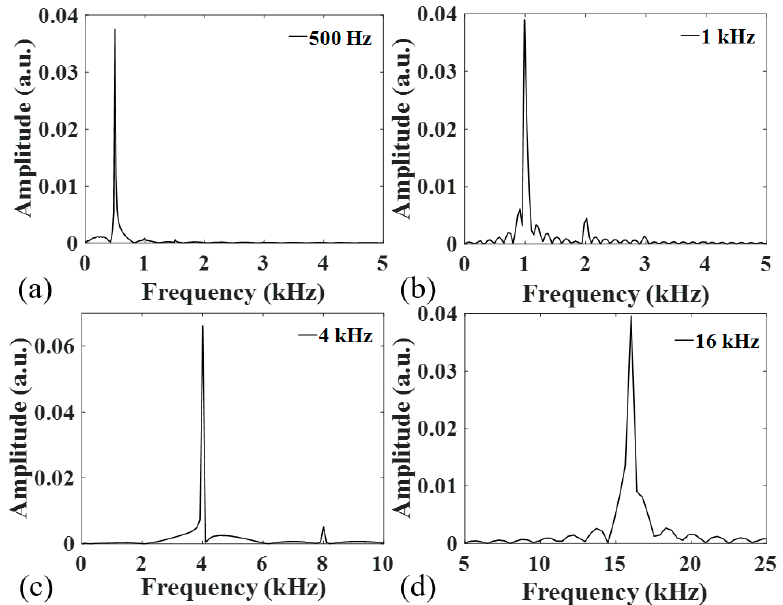
Figure 7. Frequency spectra of the detected signals with frequencies of ( a ) 500 Hz, ( b ) 1 kHz, ( c ) 4 kHz and ( d ) 16 kHz.